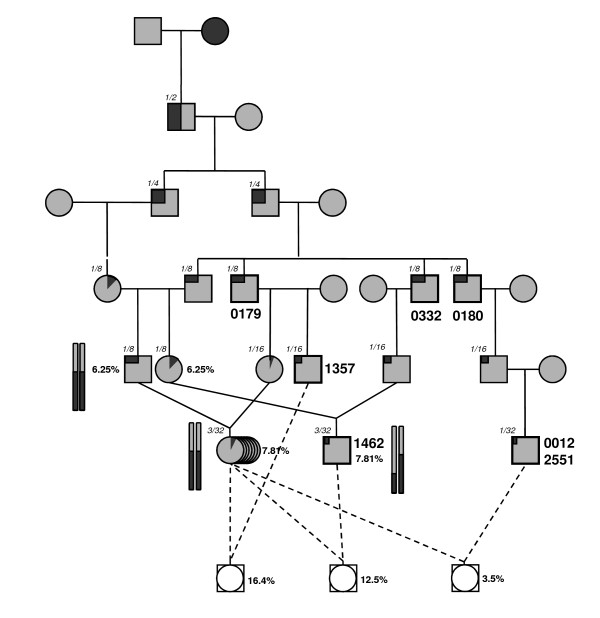
Structure of the SSC1 pedigree. The 7 different recombinant sires are noticed with a bold square and the sire name. Italic numbers indicate the MS proportion in the genome. The black chromosome pairs represent the individuals carrying a homozygote congenic MS chromosomal segment in the QTL region. The dotted lines indicated crosses realised between recombinant sires and locally MS/MS dams. For inbred animals, inbreeding coefficients is indicated.